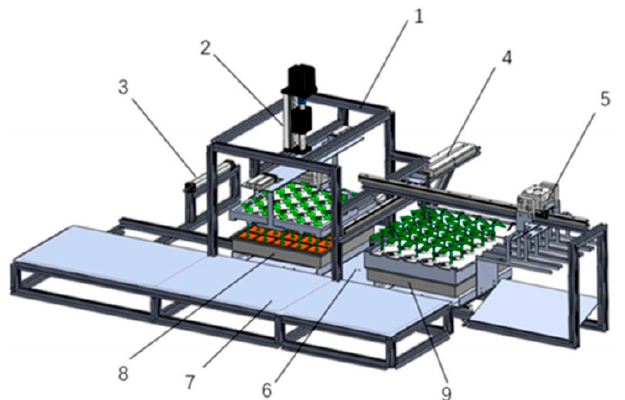
Figure 3. HAU-22 fully automatic grafting robot developed by Huazhong Agricultural University: 1. Rack; 2. Clamping-lifting device; 3. Seedling-lowering device; 4. Synchronous-cutting device; 5. Clamping and transferring device for the upper half of the rootstock seedlings; 6. Plug tray-posi- tioning device; 7. Upper seedling platform; 8. Scion-seedling plug tray; 9. Rootstock-seedling plug tray. Table 1. Comparison of the characteristics of the vegetable grafting robots based on splice grafting.